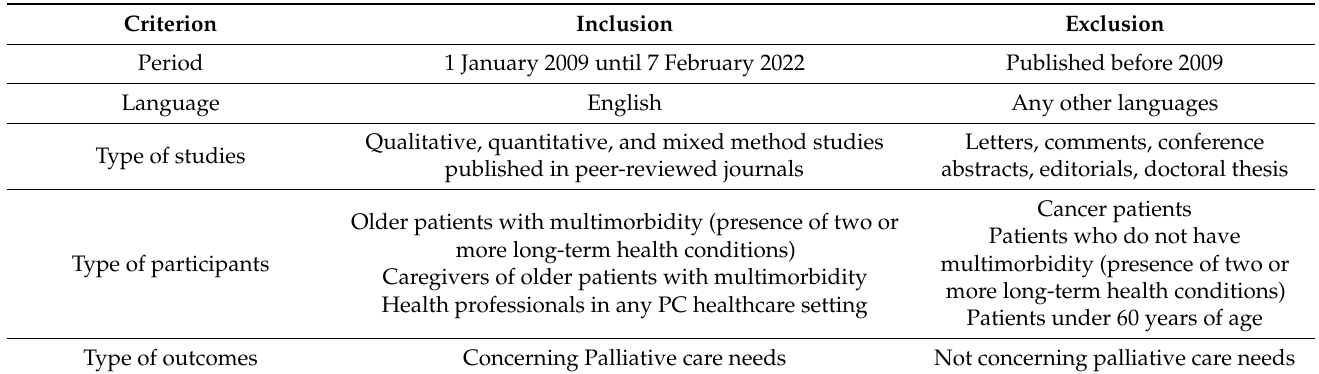
Table 1. Inclusion and exclusion